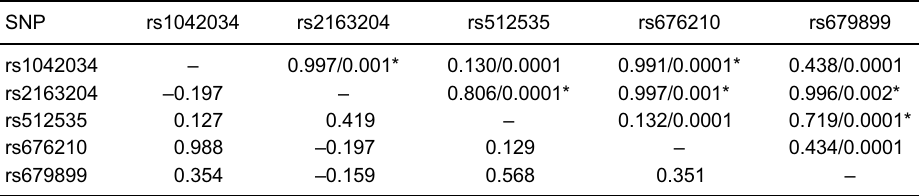
Table 3. Standardized linkage disequilibrium coef fi cients (D 0 ) among fi ve apolipoprotein B gene single nucleotide polymorphisms (SNP).